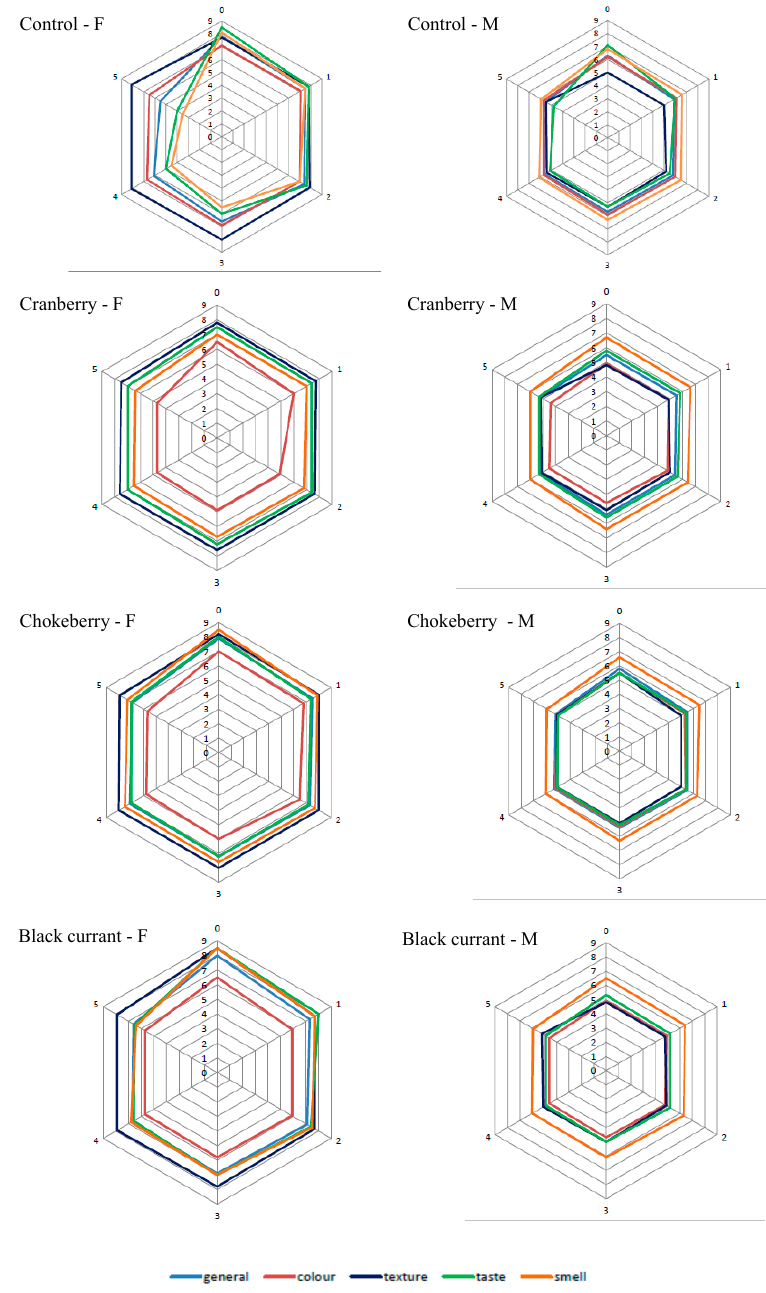
Figure 3. Sensory properties of fried ( F ) and microwaved ( M ) snacks made from Jerusalem artichoke flour with addition of fruit powders during storage for 5 weeks.